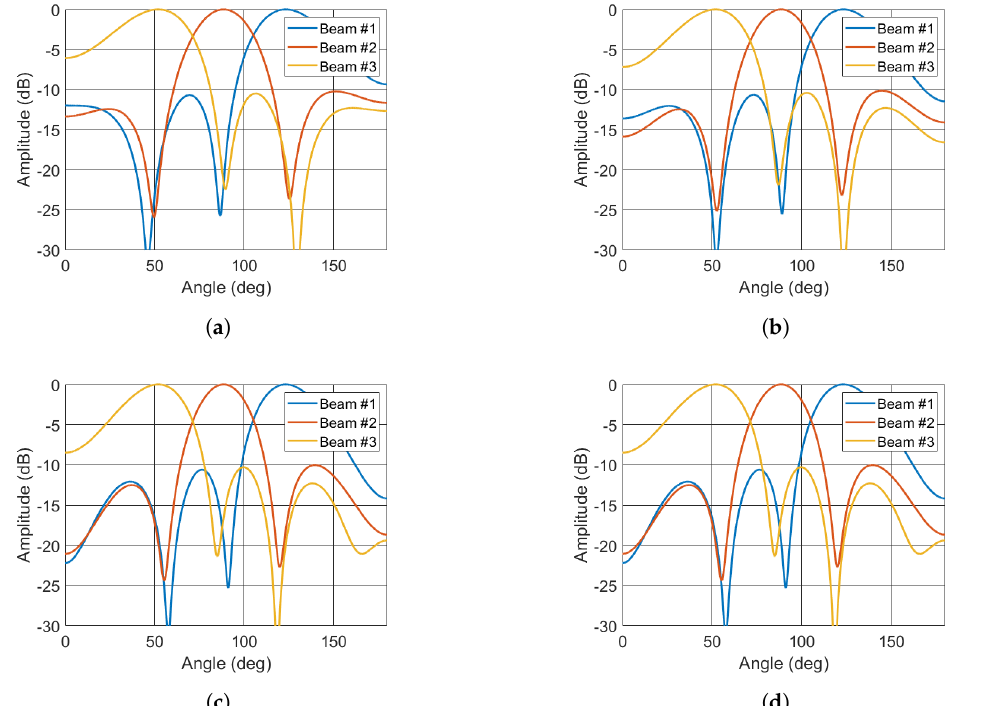
Figure 20. Calculated array factor radiation pattern when the outputs of the proposed Blass matrix (Figure 8) is used to excite the phased array at: ( a ) 27 GHz; ( b ) 29 GHz; ( c ) 31 GHz; and ( d ) 33